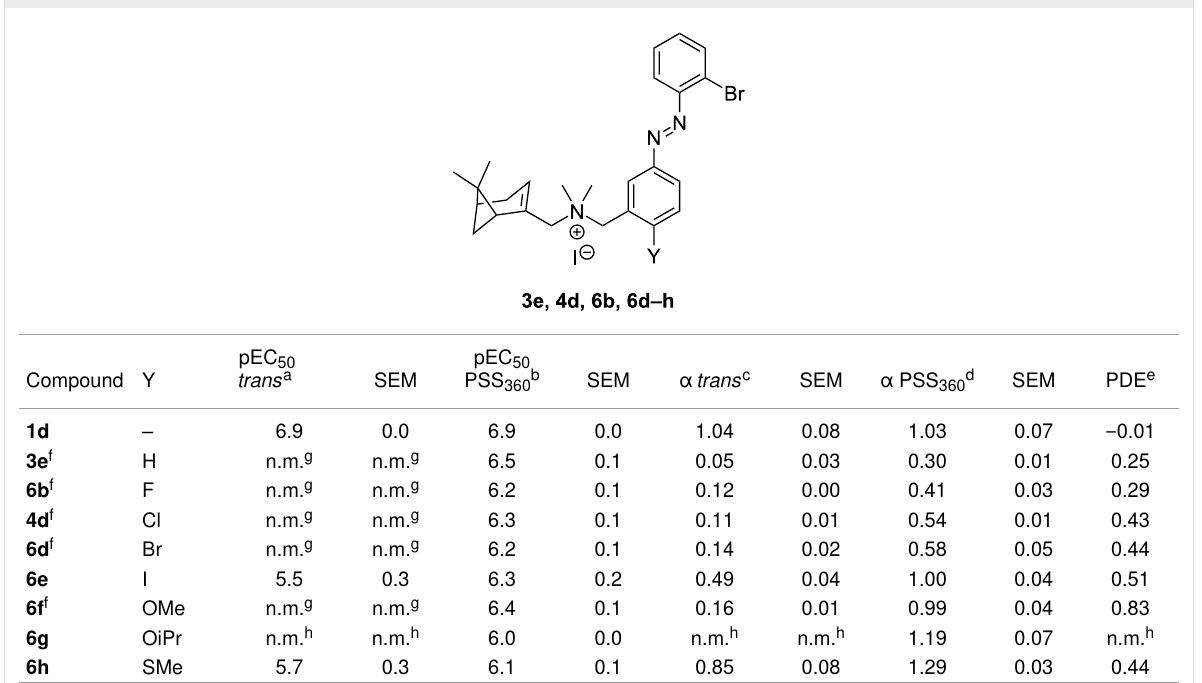
Table 4: Structure and results of functional characterization of compounds 3e , 4d , 6b and 6d–h .